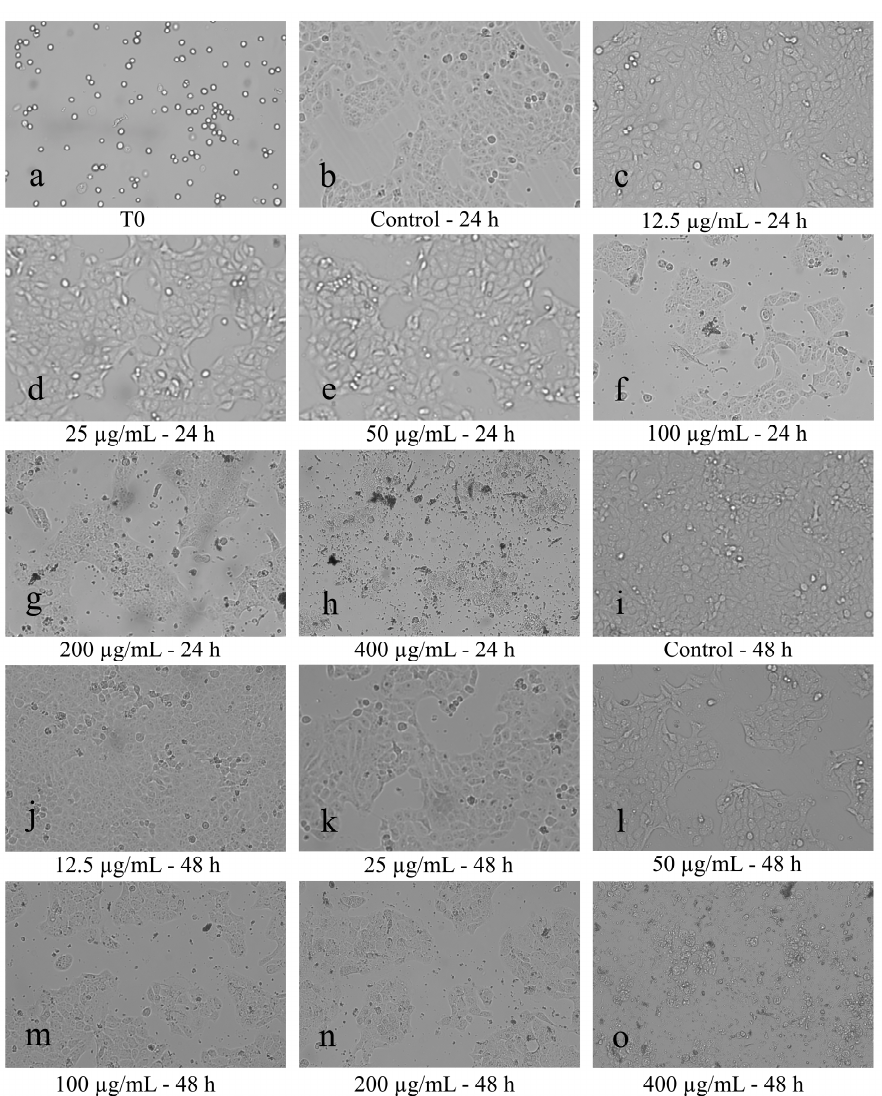
Figure 3. Cell morphology after UBE treatment on CAL 27 cells, after 24 h ( c – h ) and 48 h